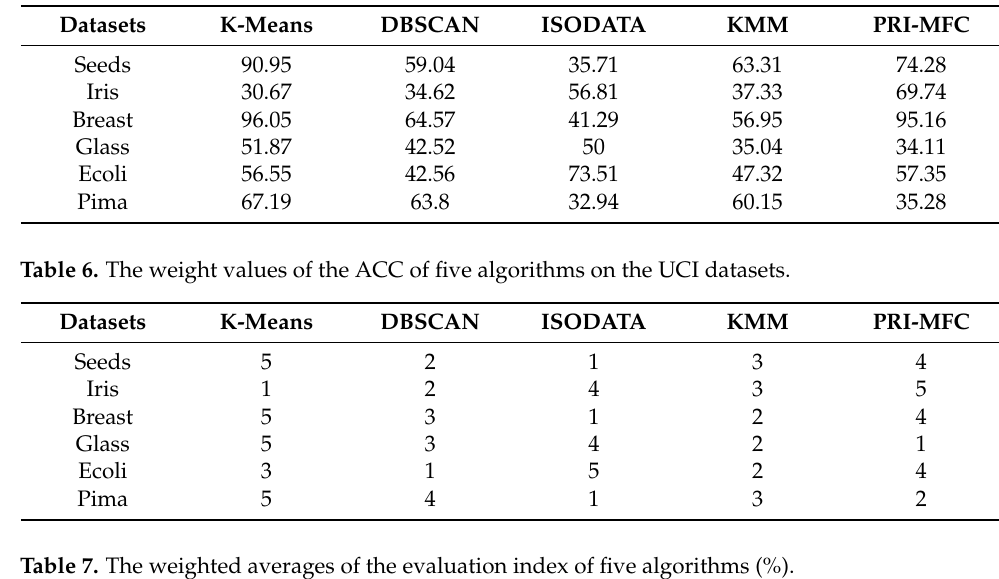
Table 7. The weighted averages of the evaluation index of five algorithms (%). Evaluation Metrics K-Means DBSCAN ISODATA KMM PRI-MFC ACC